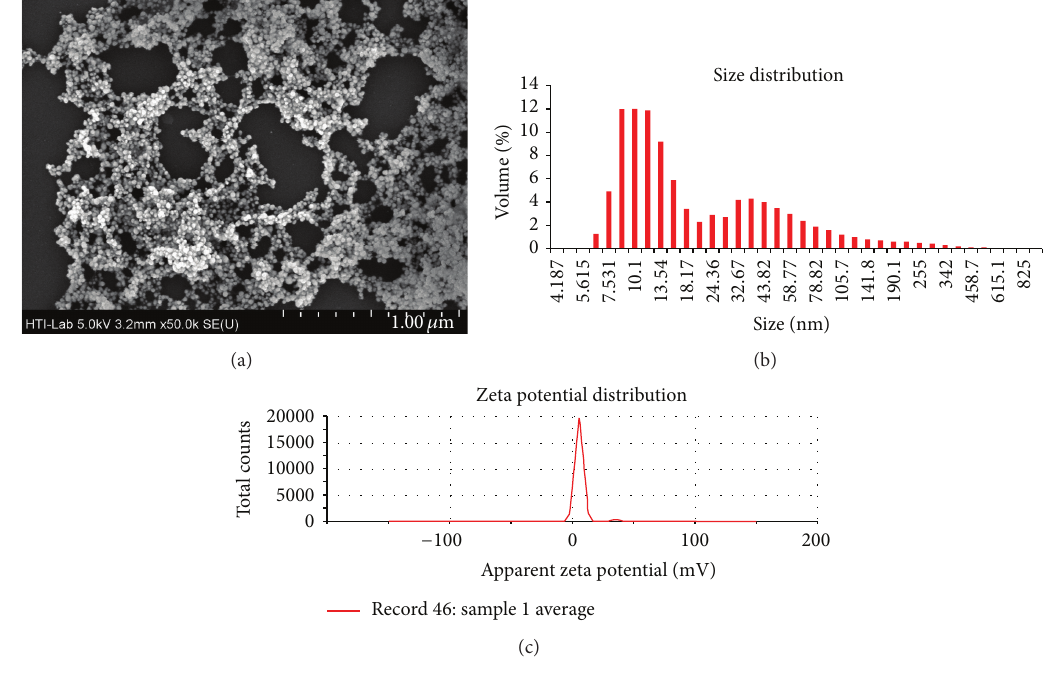
Figure 3: (a) FESEM images, (b) particle size distribution, and (c) zeta potential spectra of AgNPs.